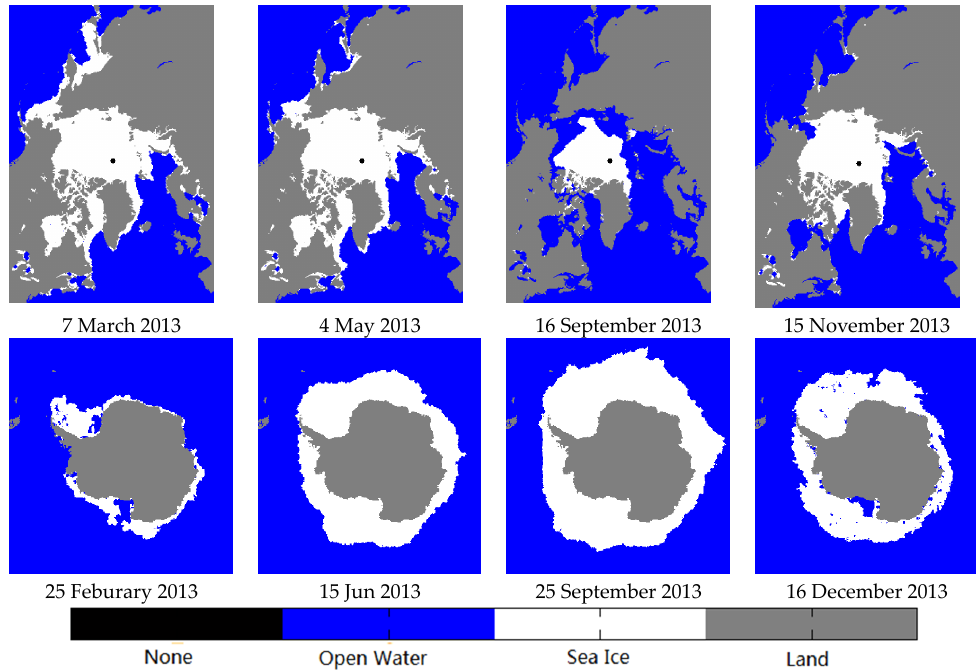
Figure 5. Example daily Polar sea ice extent from HY2-SCAT.